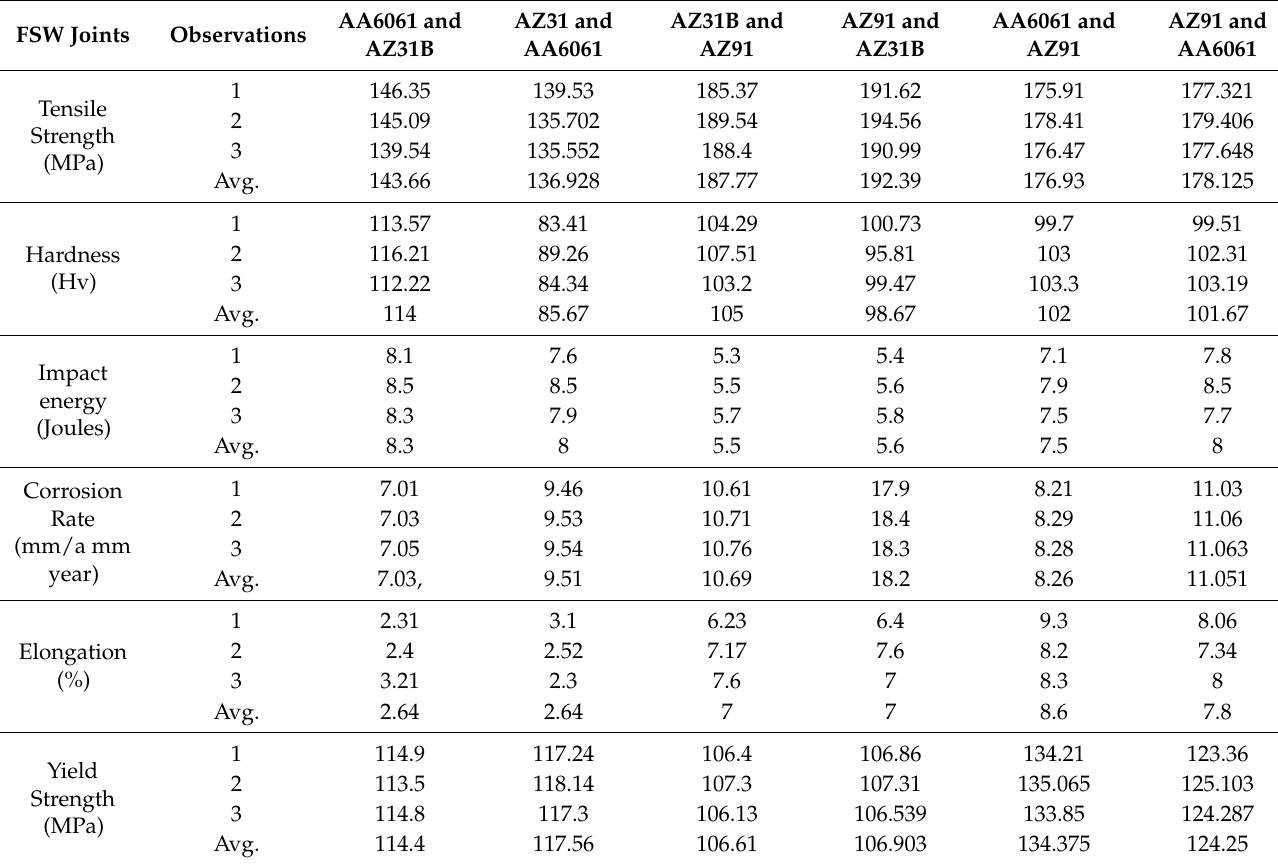
Table 4. Observations of hardness, impact energy, corrosion, and tensile